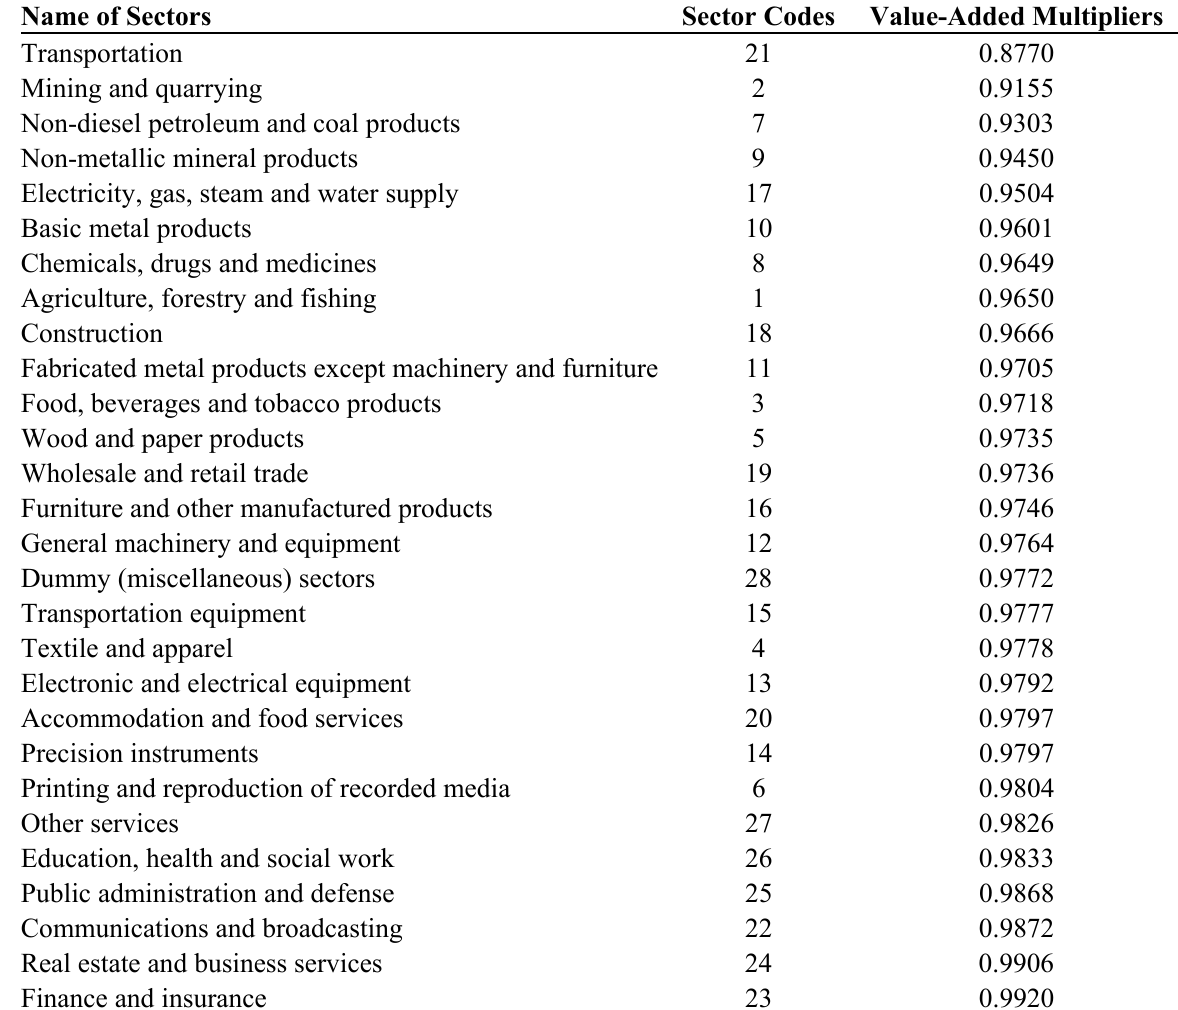
Table 2. Value-added multipliers for non-diesel sectors in